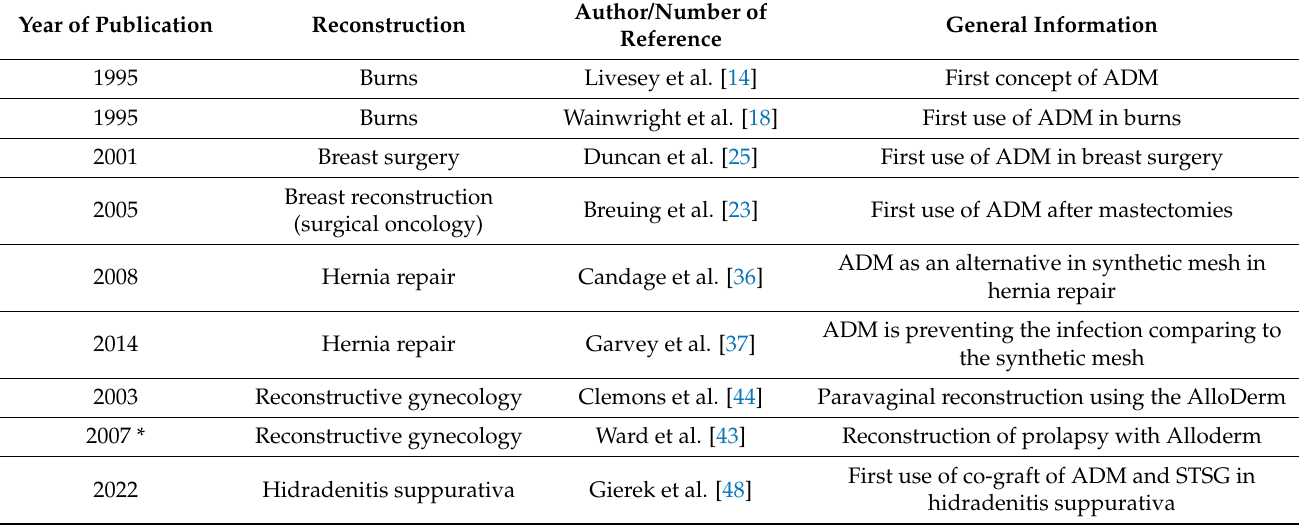
Table 2. Summary of the literature, brief chronological characteristics of manuscripts on acellular dermal